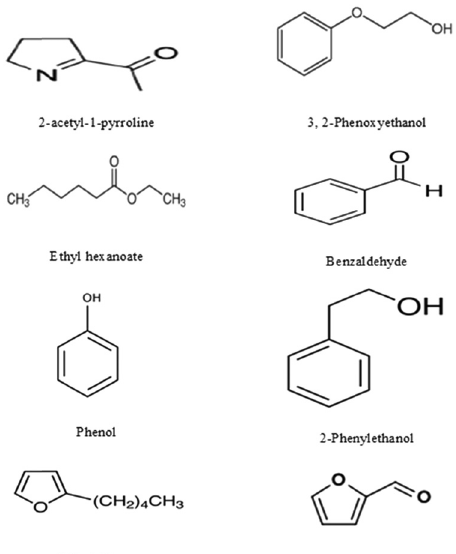
Figure 1: Structural formula of aromatic compounds present in Asian